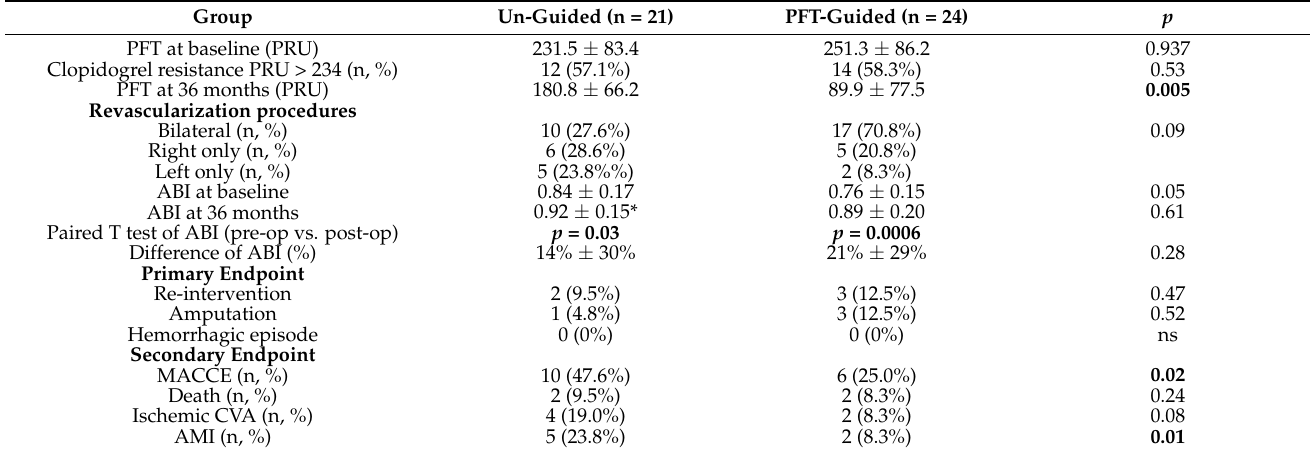
Table 2. PFT-guided dual anti-platelet treatment prevents MACCE in diabetic PAD